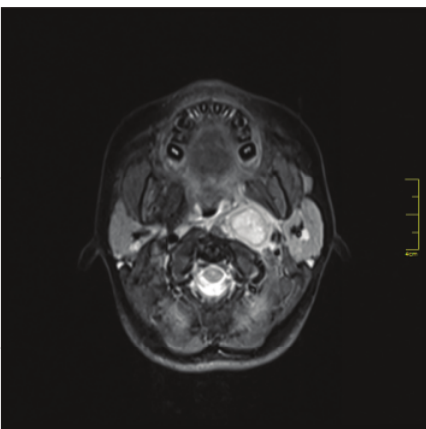
Figure 2: In the computerized tomography, there was a 37 × 30 mm size centrally hypometabolic, peripherally hypermetabolic mass starting from the base of the nasopharynx occupying the left Rosenmuller fossa. The mass obliterated the carotid space extending to the left parapharyngeal